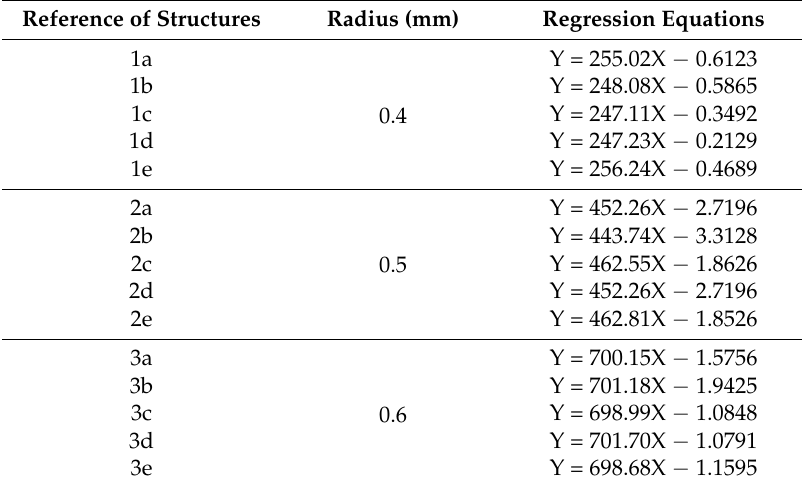
Table 2. Linear regression equations for H/W = 4.